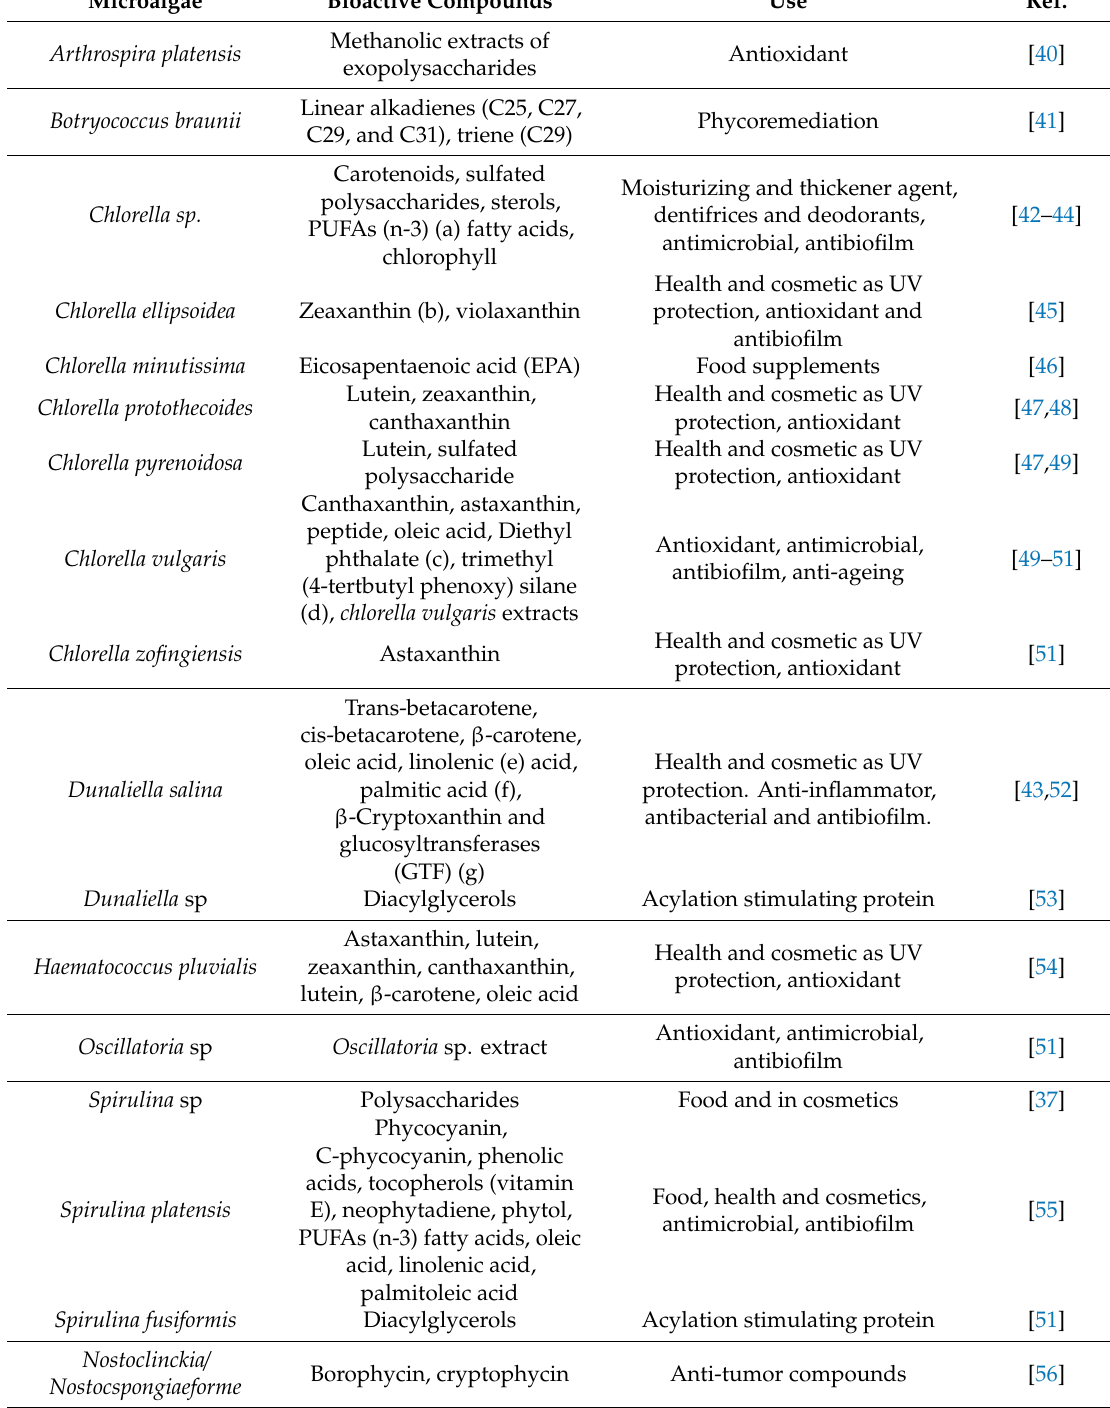
Table 2. Principal bioactive compounds extracted from